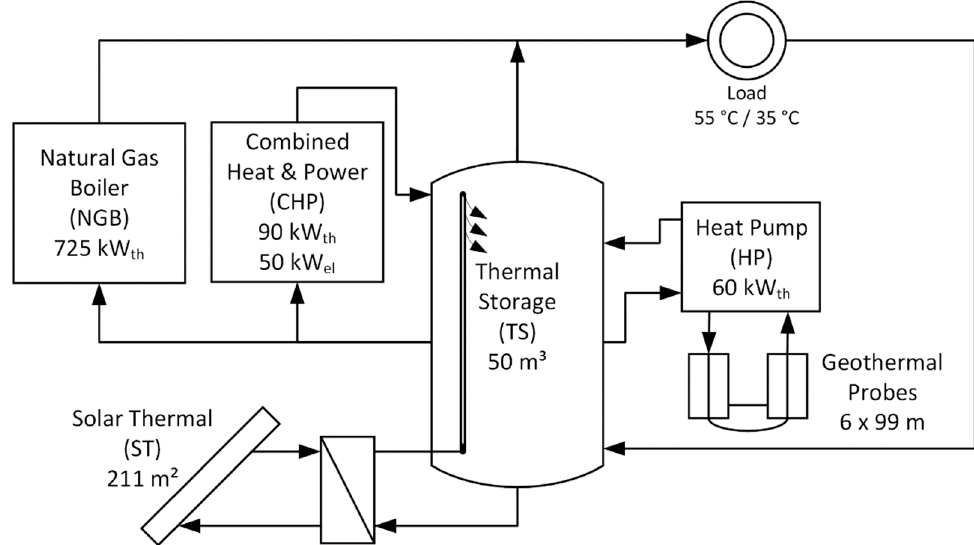
Figure 1. Schematic diagram of the heating station of the local heating network in Kempen (Germany).